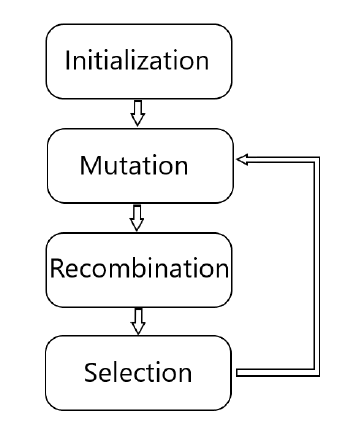
Figure 14. Phases of differential evolution for the parametric optimization of the proposed